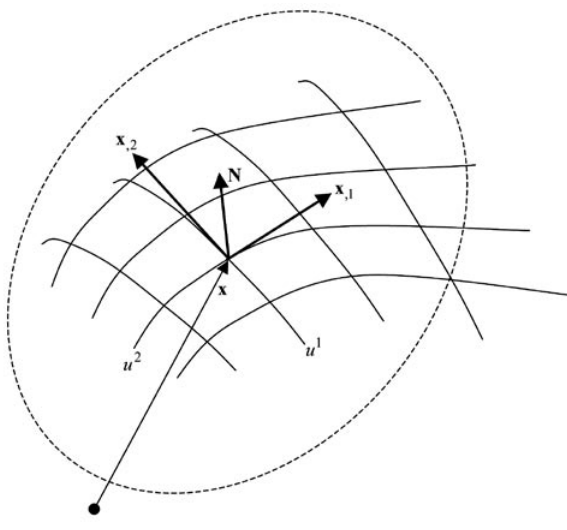
Figure 3 A surface with vectors x ,1 and x ,2 tangent, at point x , to the parameter curves of the surface. The tangent vectors define the surface’s tangent plane (shown by means of a dashed ellipse) and a normal vector N (equation 6).